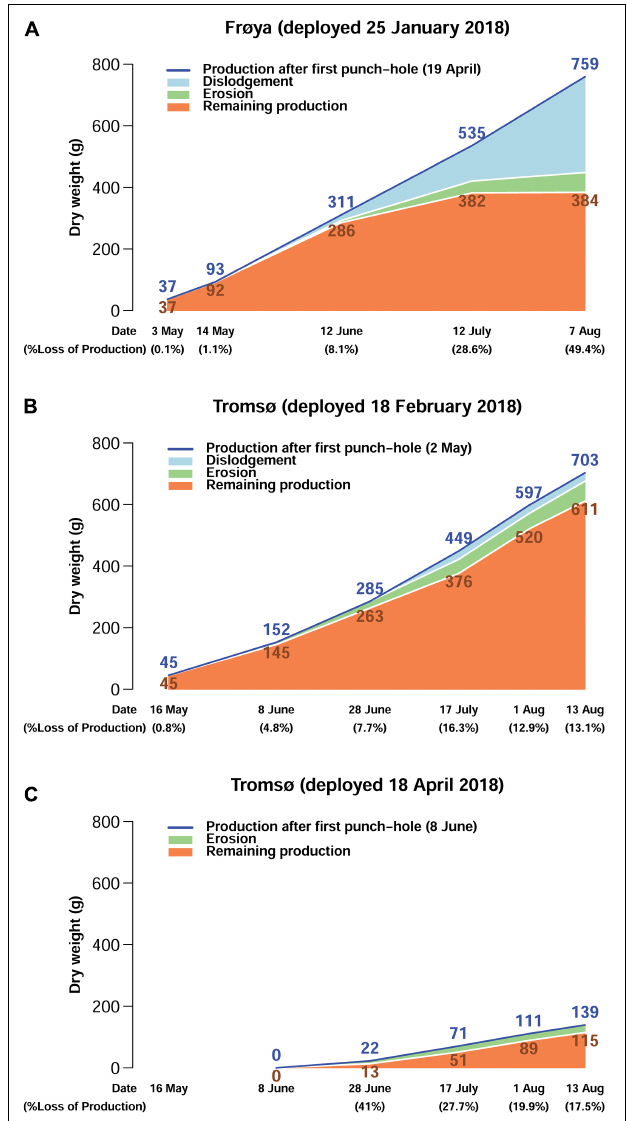
FIGURE 5 | Estimated production, dislodgement, erosion, and remaining production on rigs for the whole experimental stock of kelp at different points of sampling (g DW) for Frøya (A) , Tromsø February (B) , and Tromsø April (C) deployment.